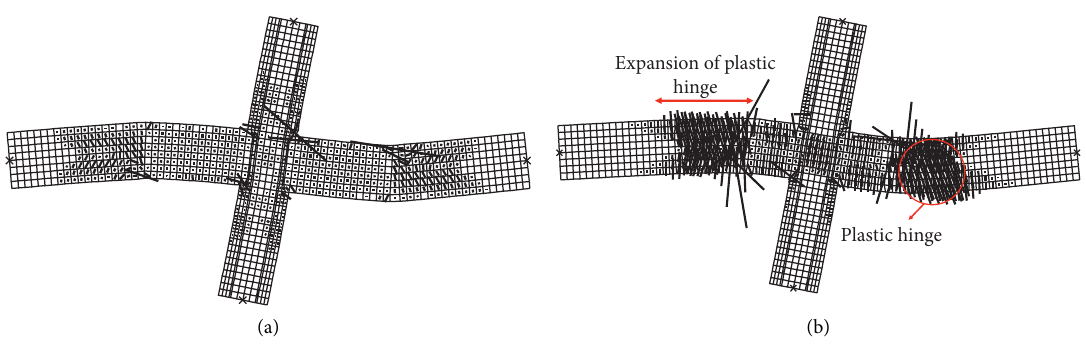
Figure 18: Plastic hinge location according to plate length. (a) Tested length. (b) Half of tested